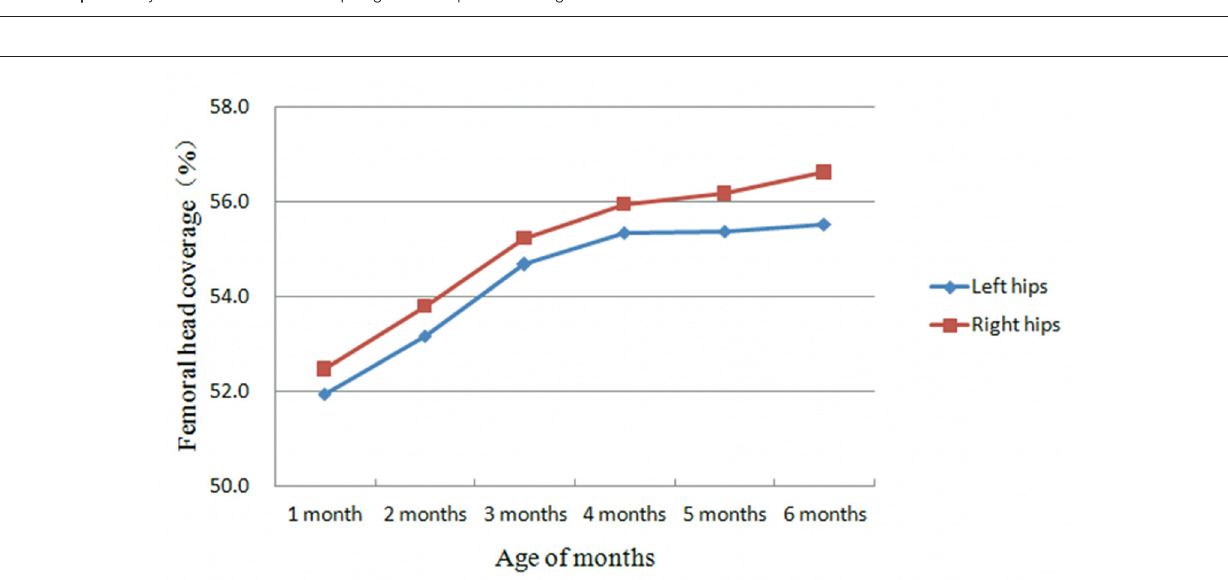
FIGURE 2 | Laterality characteristics of α and β angles development with age of months.